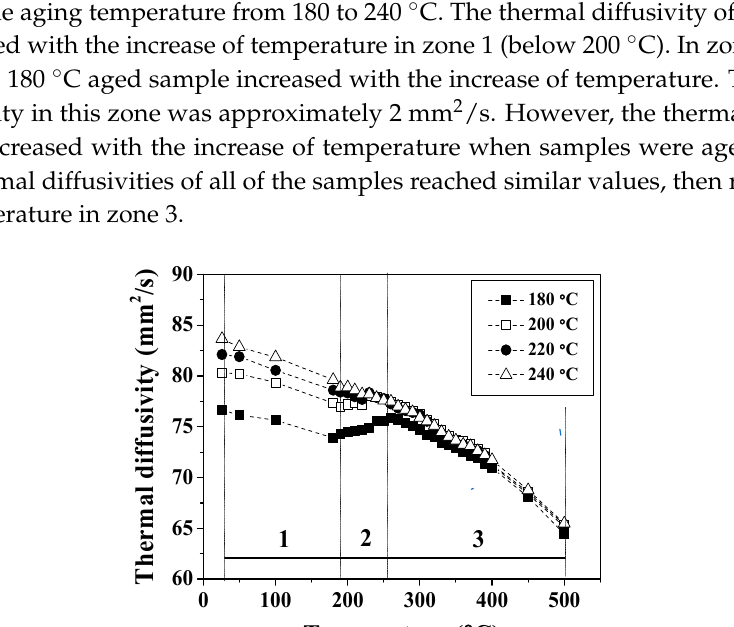
Figure 7. The thermal diffusivity changes of Al-1.1Mg 2 Si samples according to the temperature increase with various contents and aging treatment conditions.